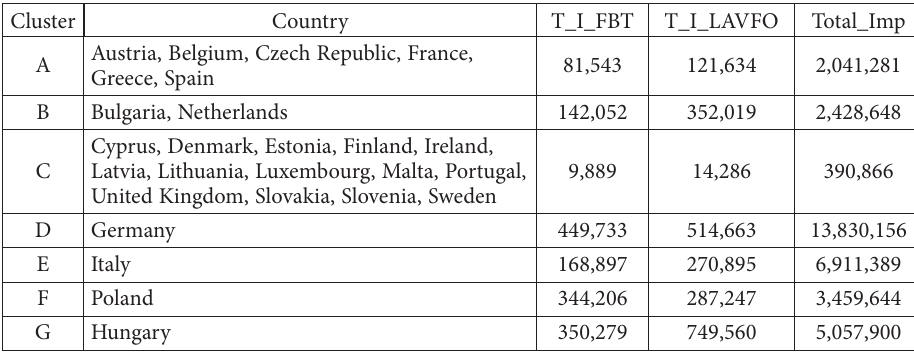
Table 5. EU states grouping according to the average volume at group level of Romania’s imports in 2016 (thousands euro) (source: authors based on NIS, 2018) Cluster